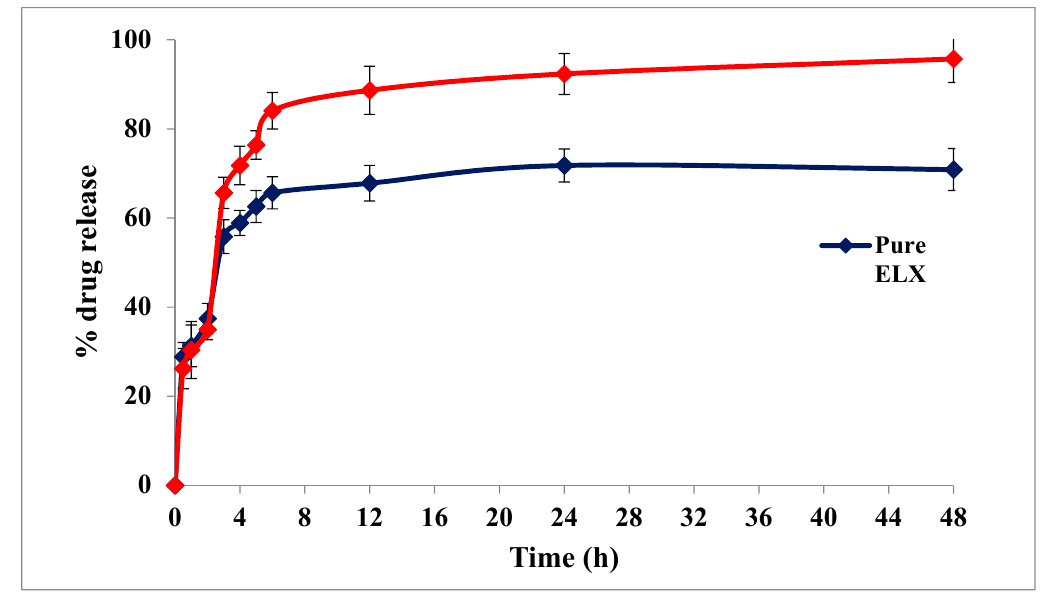
Figure 4. A comparative in vitro release profile of pure ELX and ELX loaded SLNs (F2).